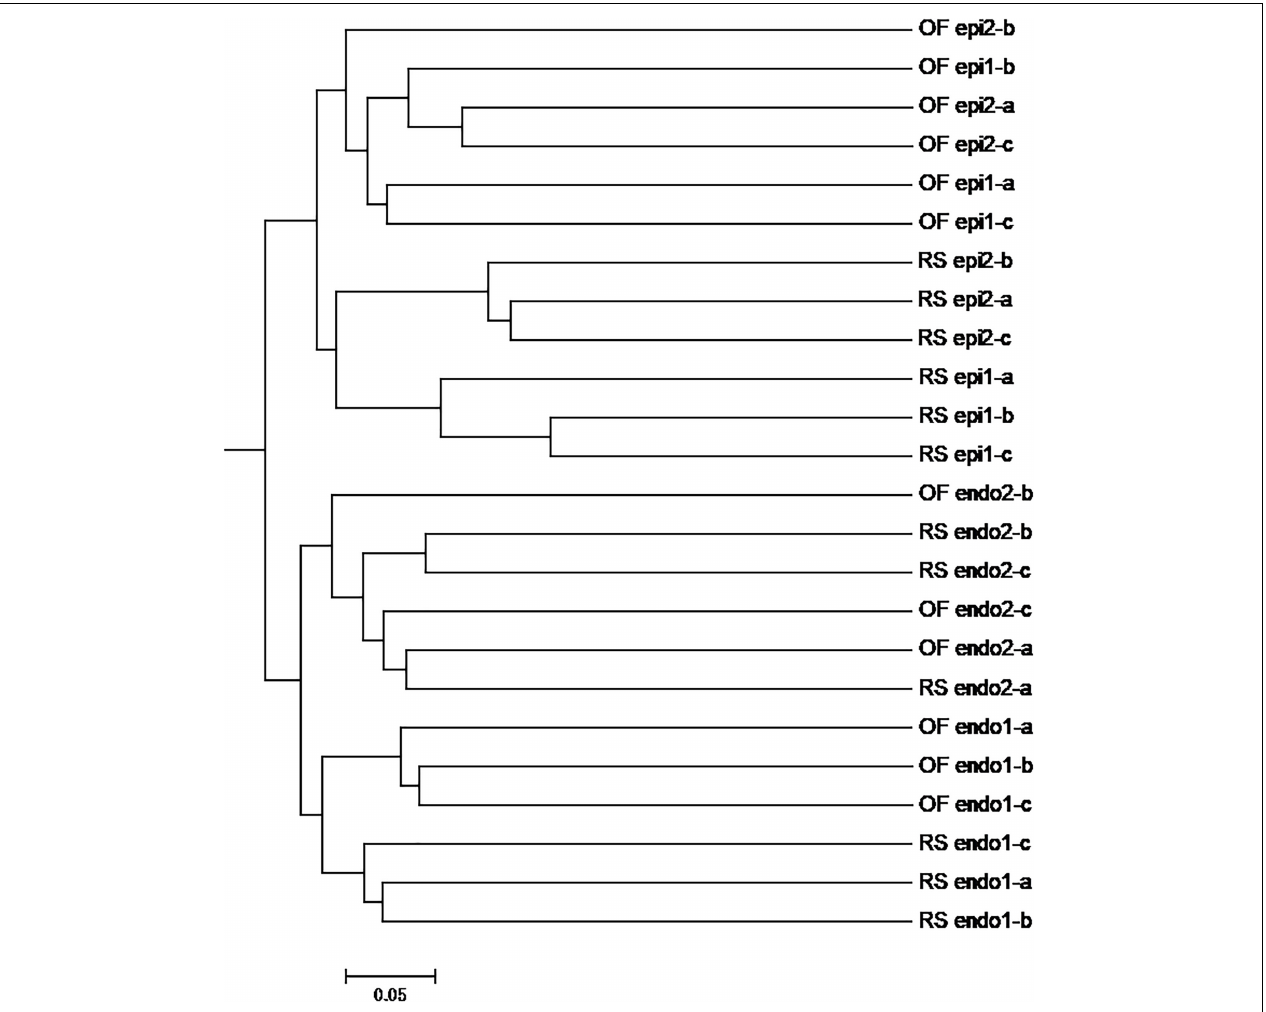
FIGURE 5 | UPGMA analysis of OTUs of fungal community in different kiwifruit samples based on unweighted_unifrac distance. Note: In the samples, the prefix "RS" and "OF" mean rain-shelter cultivation and open-field cultivation, respectively; "epi" and "endo" represent epiphytic and endophytic, respectively; "1" and "2" indicate “Hongyang” and “Cuiyu” cultivars,